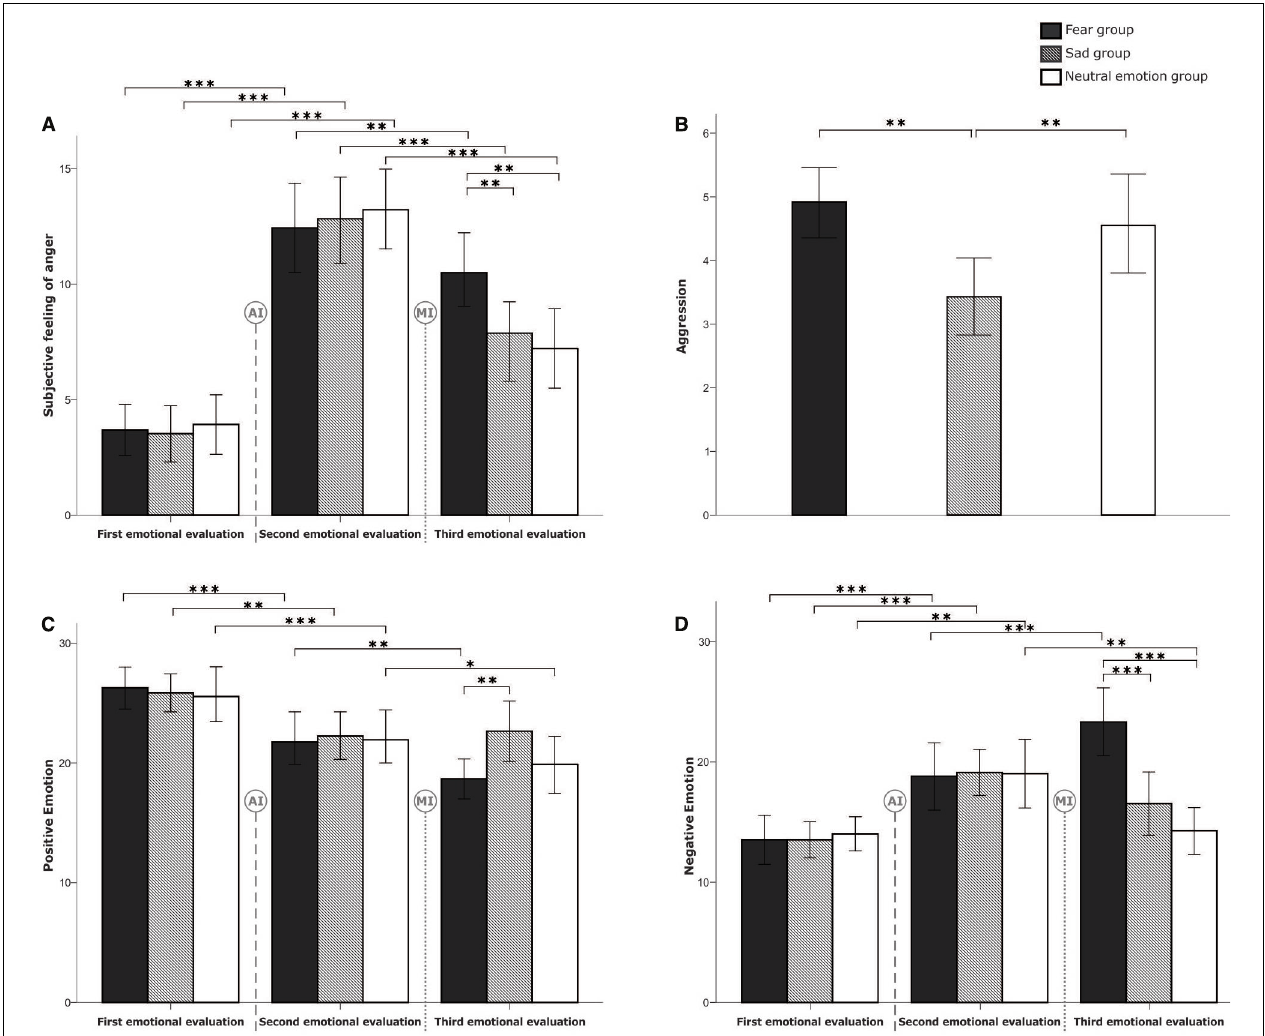
FIGURE 4 | Comparisons of emotional change and the level of aggressive behavior among the three experimental conditions in Study 2. Participants’ subjective feelings of anger, positive emotion, and negative emotion in the three experimental stages (i.e., first emotional evaluation, which was administered before anger induction; second emotional evaluation, which was administered after anger induction; and third emotional evaluation, which was administered after the fear/sadness/neutral